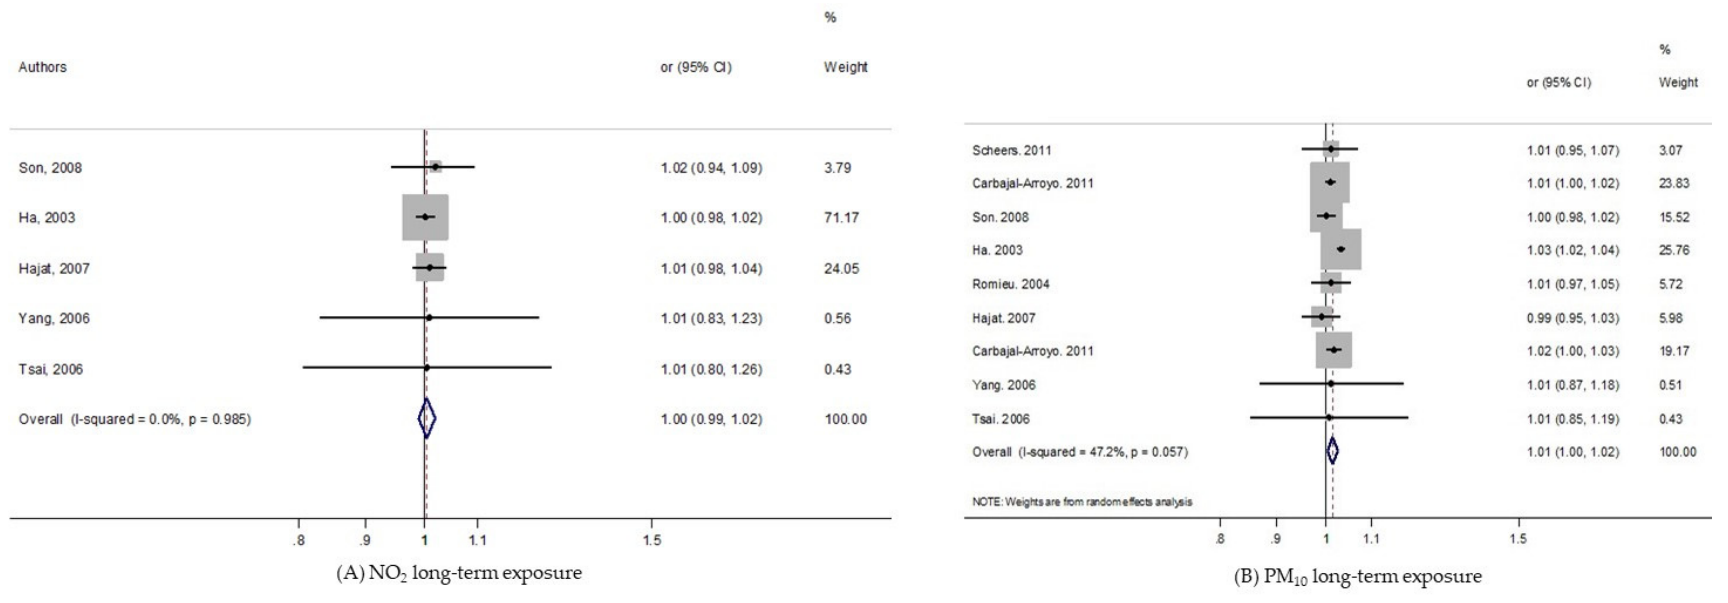
Figure 2. Forest plots for combinations of post-neonatal death all-causes and pollutant. The size of each square represents the weight that contributes to the combined effect, respectively for: ( A ) NO 2 ; ( B ) PM 10.